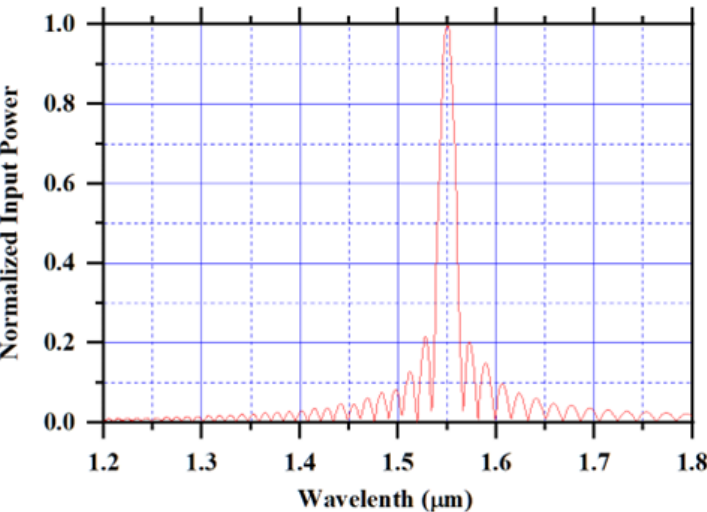
Figure 5. Normalized input power of the design